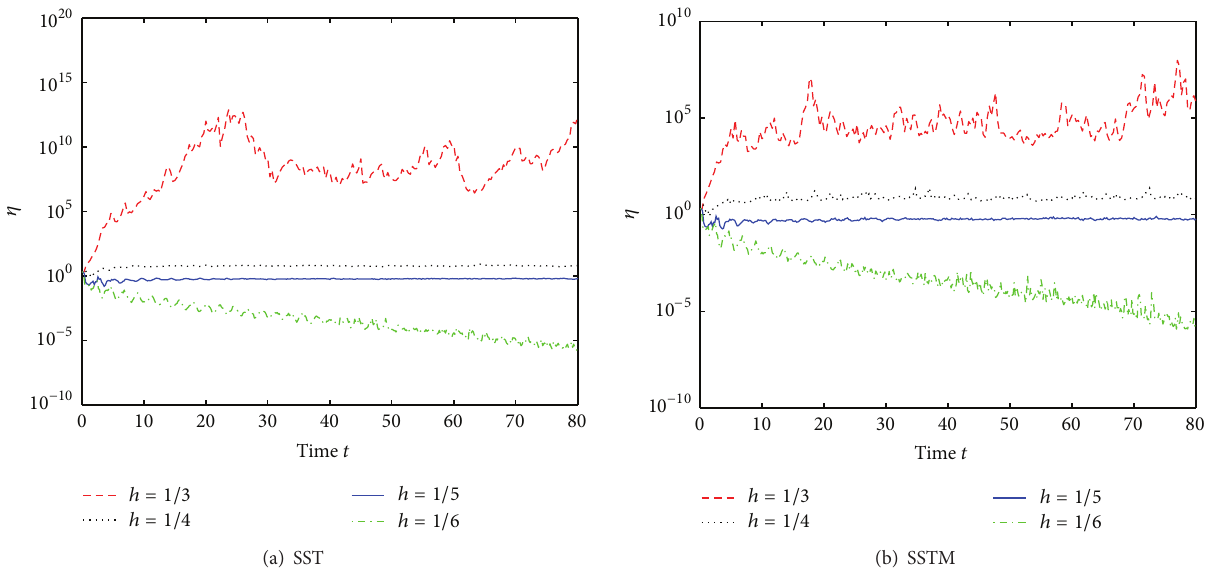
Figure 5: Mean-square stability comparison of SST and SSTM for the SDHNNs (43), Case 2, 𝜃 = 0.2